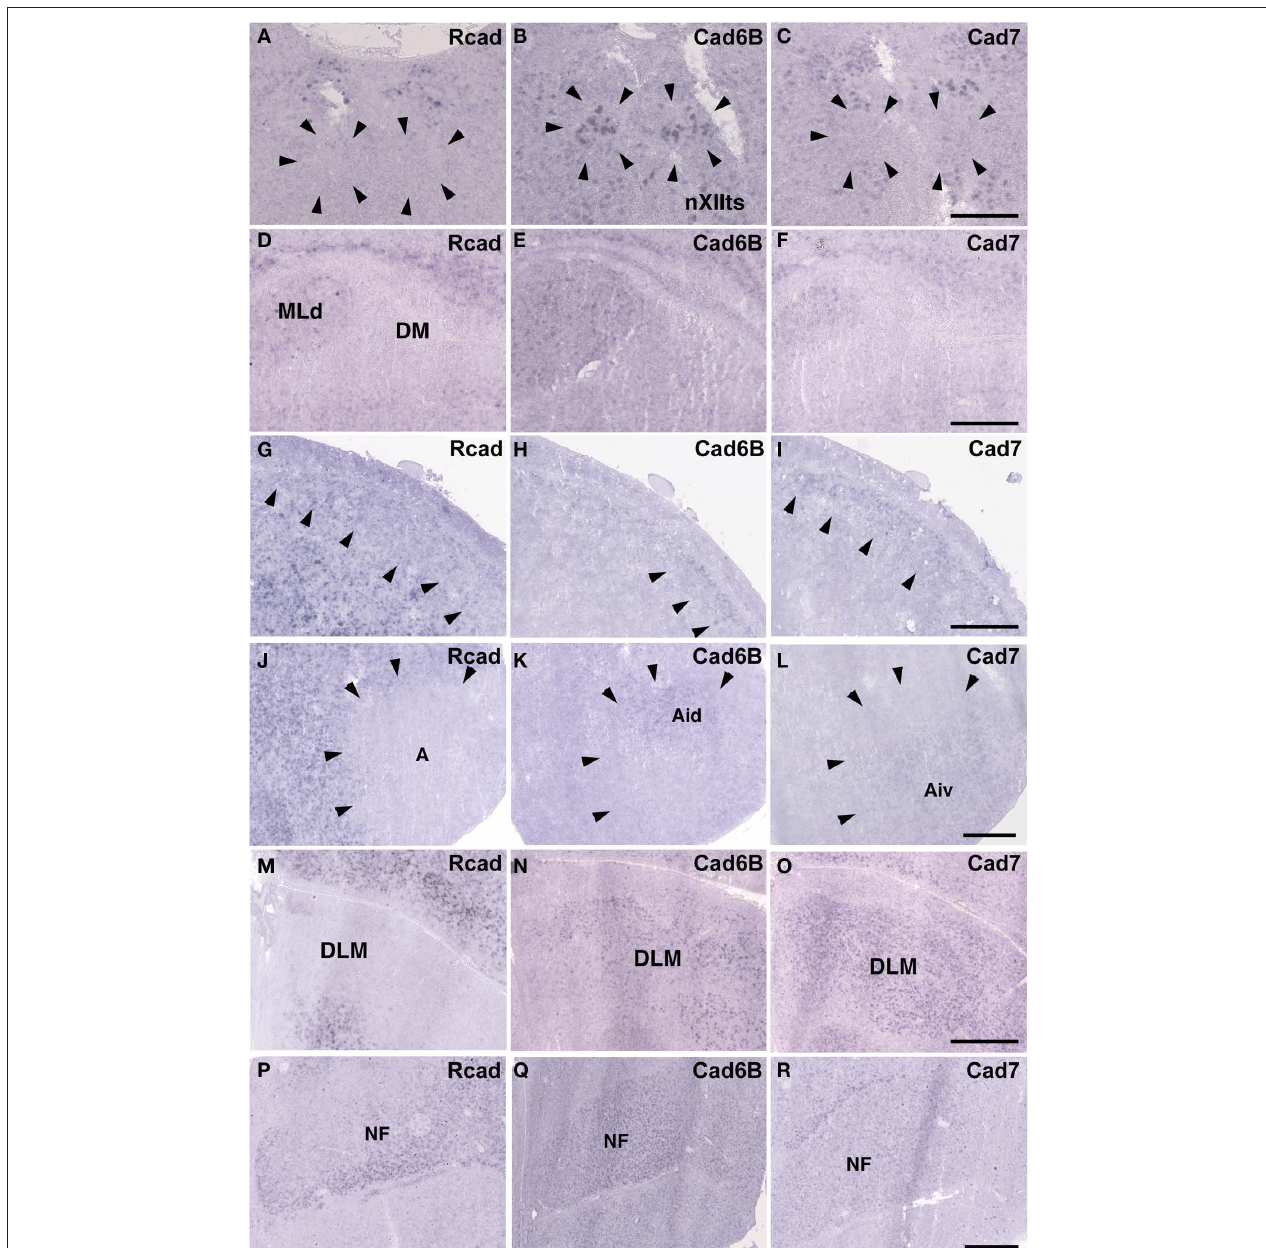
Figure 12 | Cadherin expressions in vocal areas of the brainstem and corresponding areas of ring dove to telencephalic vocal areas. In situ hybridization for Rcad (A,D,g,J,M,P) , cad6B (B,e,H,K,N,Q) , and cad7 (C,F,i,L,O,r) . Cadherin expressions in nXIIts (A–C) , DM (D–F) , NCL (g–i) , Ai (J–L) , DLM (M–O) , and NF (P–r) . Scale bars are